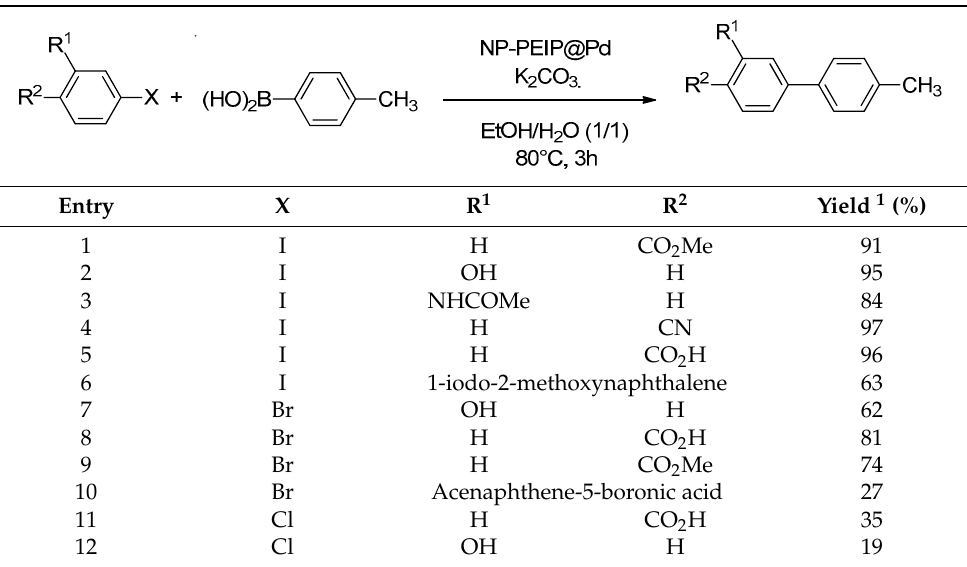
Table 2. Suzuki-Miyaura couplings involving halogenoarenes with phenylboronic acid with NP-